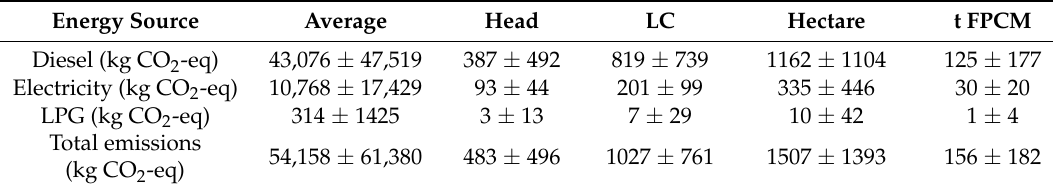
Table 2. Emission data summary on a yearly basis, averages and standard deviation (N = 285).